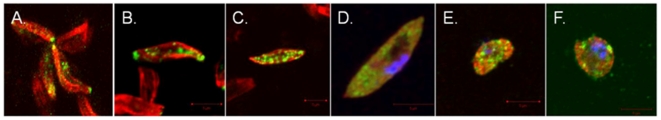
Stage III and later gametocytes visualized with anti-Pfg377 and anti-α-tubulin II antibodies.Fluorescent staining of α-tubuIin (red) generated a characteristic striated pattern, particularly in earlier gametocytes. Expression of Pfg377 (green) was not seen prior to stage III. A) stage III; B) late stage III; C) stage IV; D) late stage IV; E) stage V; F) activated female gametocyte. Nuclear material was stained with DAPI, appearing blue in colour. Parasites were magnified ×1000.